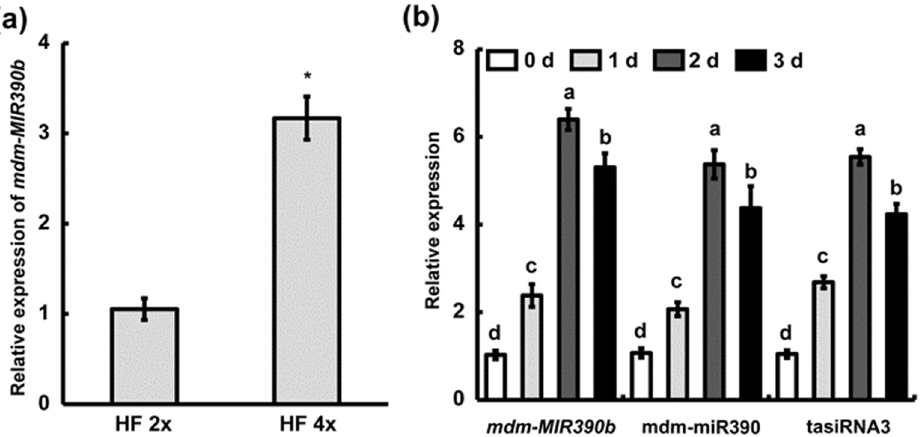
Figure 3. The analysis of the mdm-MIR390b gene, mdm-miR390, and tasiRNA3by qRT-PCR. ( a ) mdm-MIR390b expression was examined in ‘Hanfu’ and autotetraploid apple. HF 2x represents ‘Hanfu’. HF 4x represents ‘Hanfu’ autotetraploid. The vertical bars represent SDs ( n = 3). ‘*’ represents p < 0.05 (Student’s t -test). ( b ) Expression level of mdm-MIR390b , mdm-miR390, and tasiRNA3 under C. gloeosporioides infection in ‘Hanfu’. The vertical bars represent SDs ( n = 3). The different letters represent significant differences at p < 0.05 level.